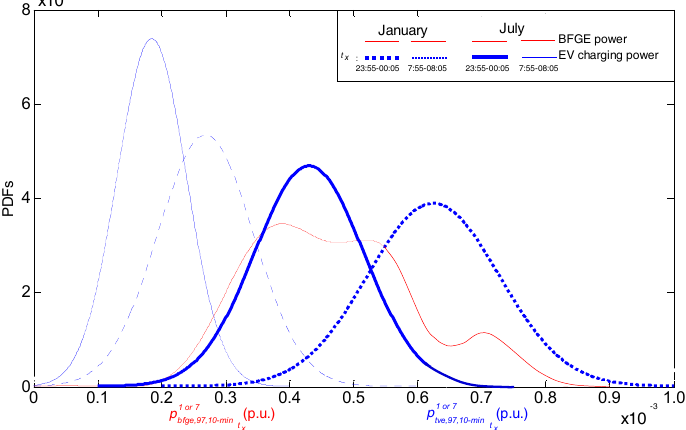
Figure 5. PDFs of BFGE power and EV charging power at node 97 during a working day (around 00:00 h and 08:00 h). Table 2. Cumulants of BFGE power and EV charging power at node 97 during a working day (around 00:00 h and 08:00 h).